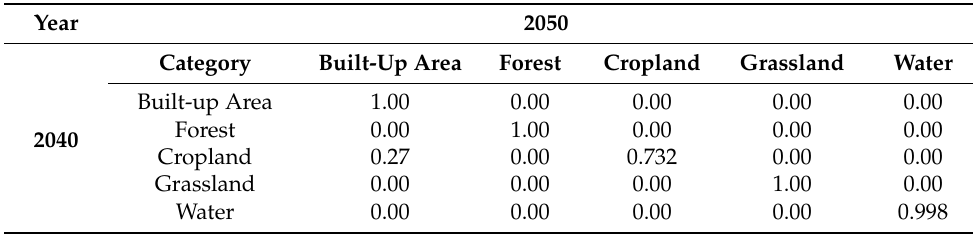
Table 12. Transition Matrix from 2040–2050.